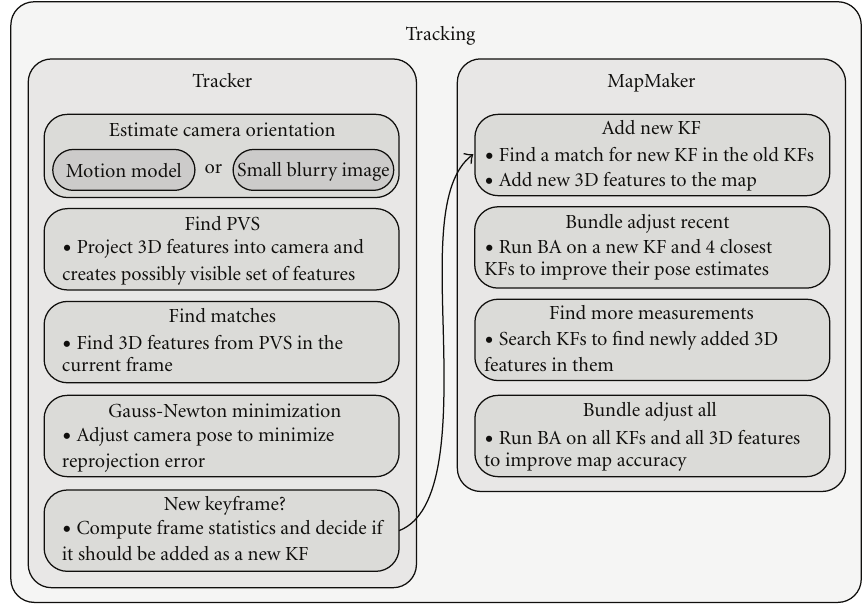
Figure 2: PTAMM tracking